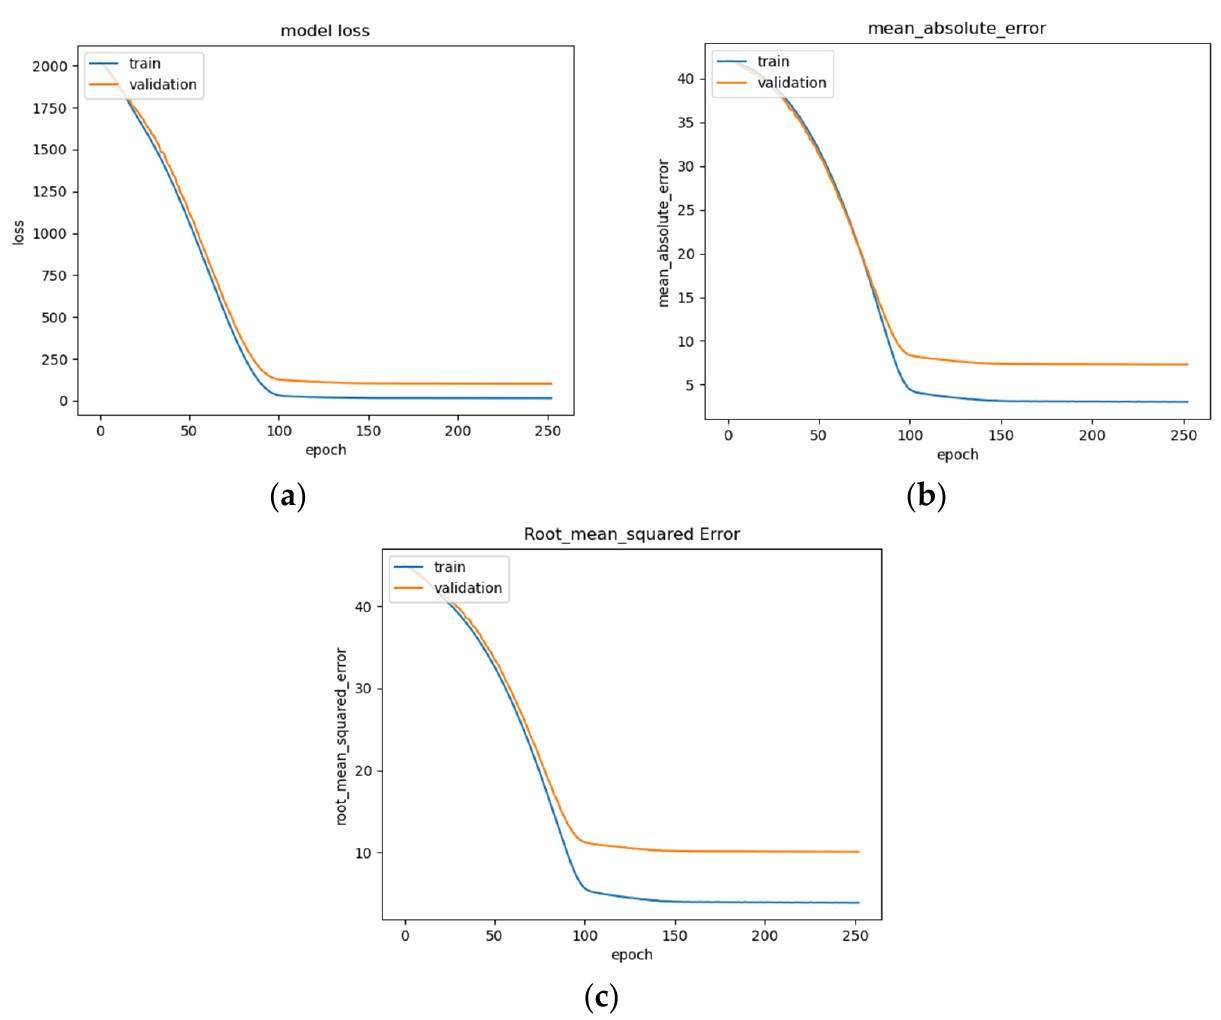
Figure 14. LSTM model performance: a) Loss (MSE) of LSTM trained on EEG data with regression analysis; b) MAE of LSTM trained on raw EEG data with regression analysis; c) RMSE of LSTM trained on raw EEG data with regression analysis.